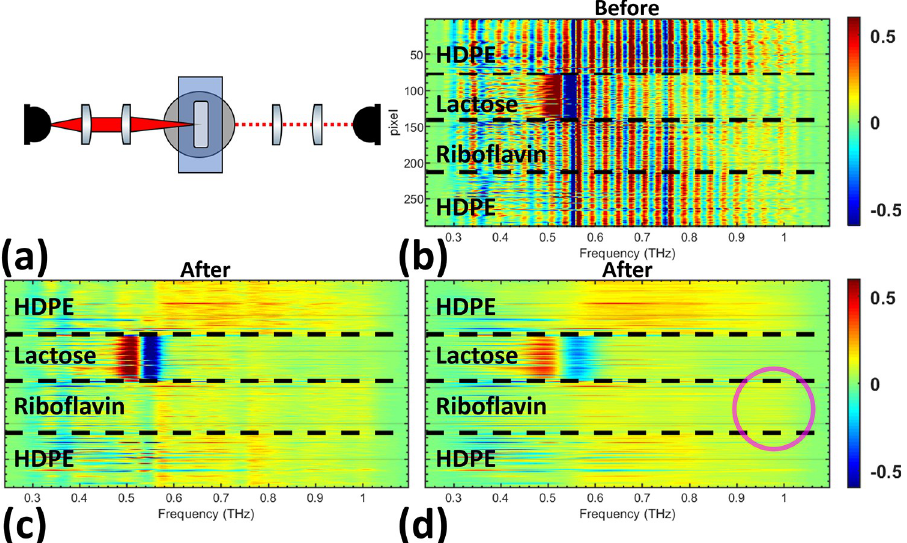
Fig 7. Measurements at θ 0 . (a) The θ 0 optical configuration used in Fig 7 is shown. The derivative spectra of all pixels is shown (b) before filtering and after using the (c) lactose Gaussian bandpass filter and the (d) riboflavin Gaussian bandpass filter in the quefrency